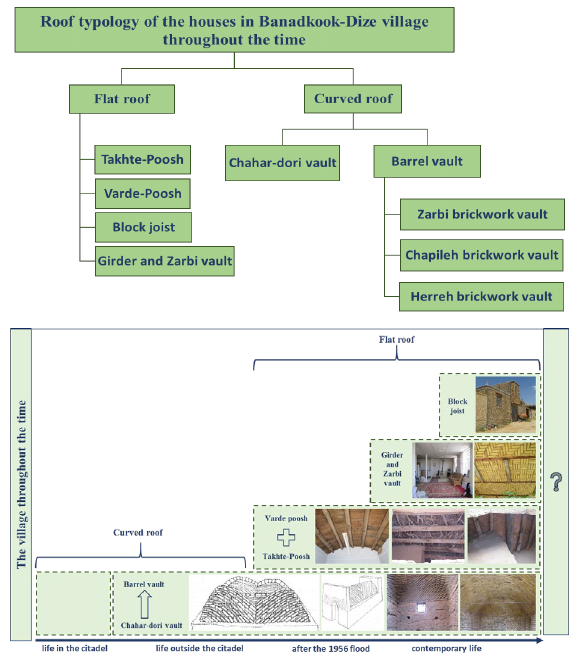
Figure 22. Roof typology of the houses in Banadkook-Dize village throughout the time,